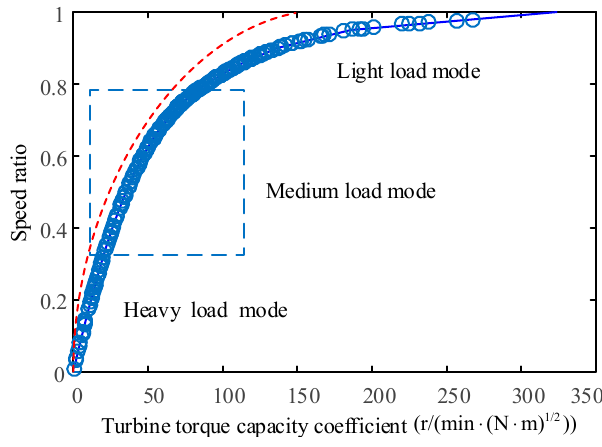
Figure 5. Loading characteristics of torque converter (TC).